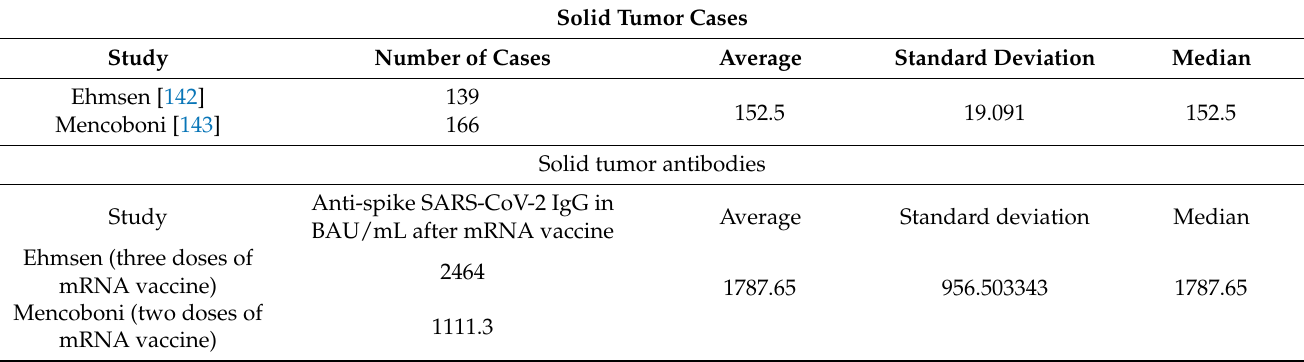
Table 5. Beneficial immune responses in solid tumor after taking mRNA vaccines.